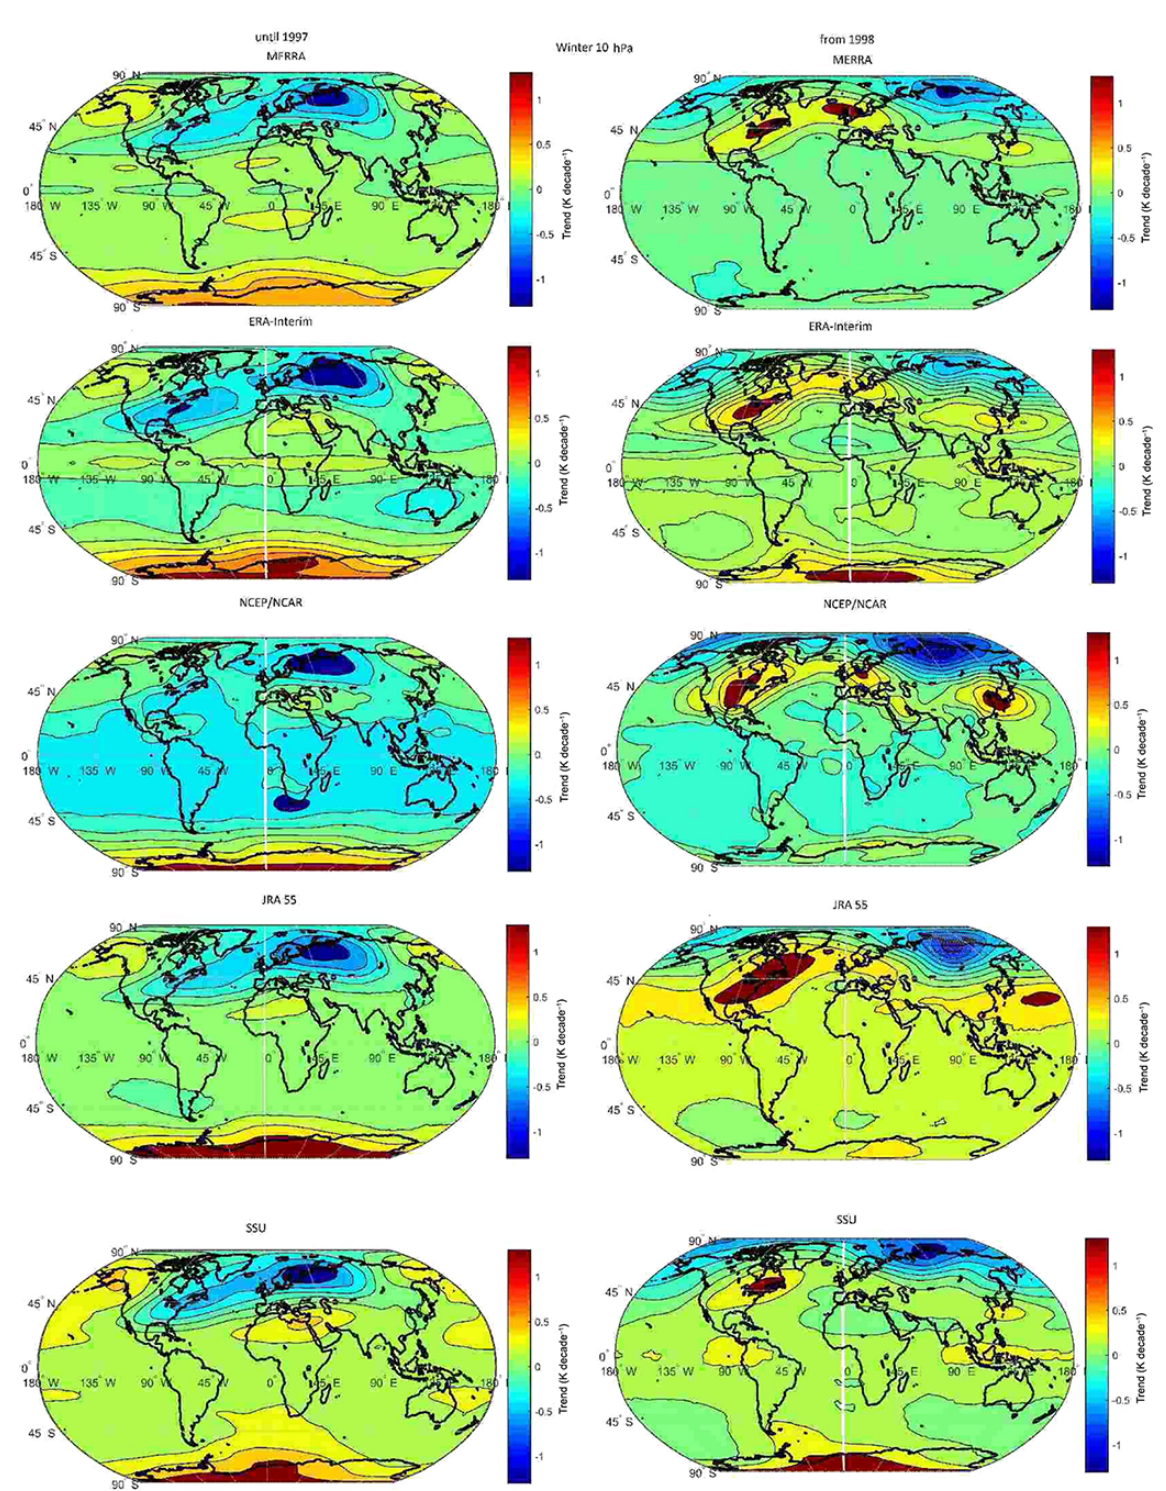
Figure 2. Temperature trends (Kdecade − 1 ) for the winter season (October–March) at 10hPa from MERRA, ERA-Interim, NCEP/NCAR, JRA-55 reanalyses and SSU channel 1 (top to bottom). Left panels show 1979–1997, right panels show 1998–2015 and statistical significance (95%) is highlighted by white